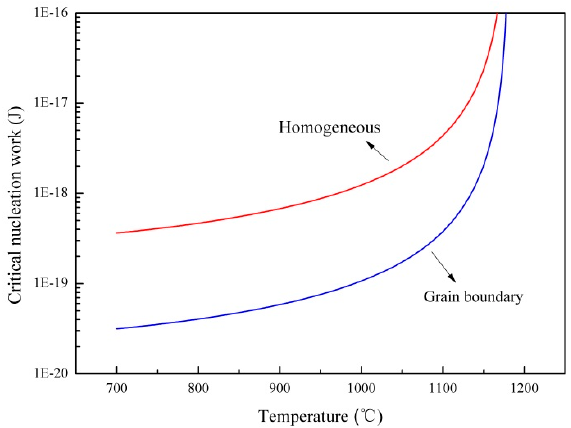
Figure 15. Comparison of nucleation work between grain boundary and homogeneous nucleation.